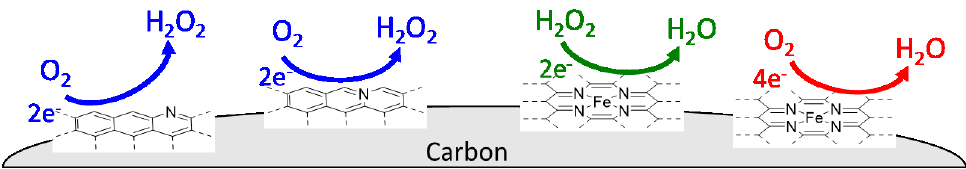
Figure 3. Hybrid mechanism for ORR over Fe/N/C catalysts.